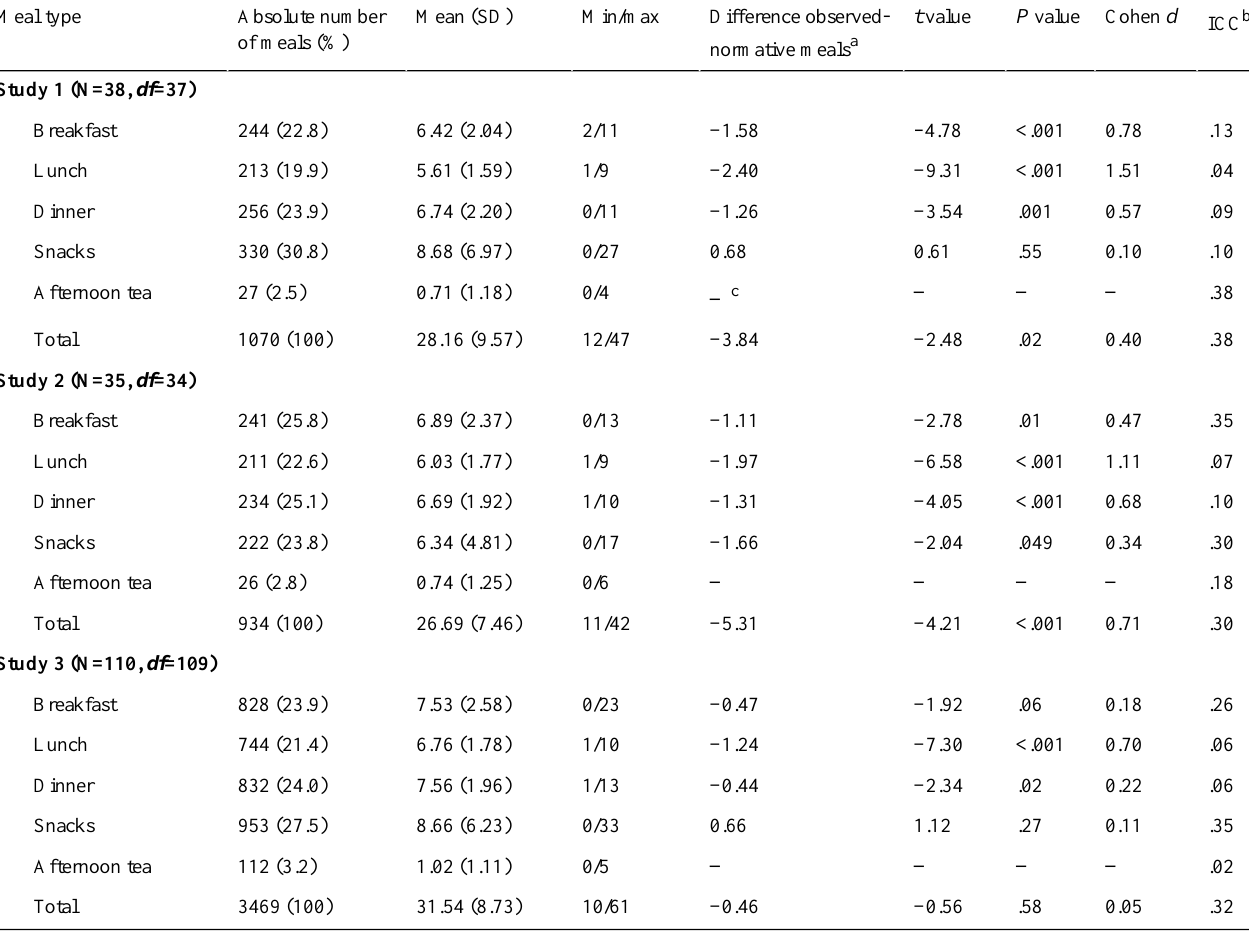
Table 1. Logged and social normative expected eating events by self-classified meal type over 8 days for studies 1, 2, and